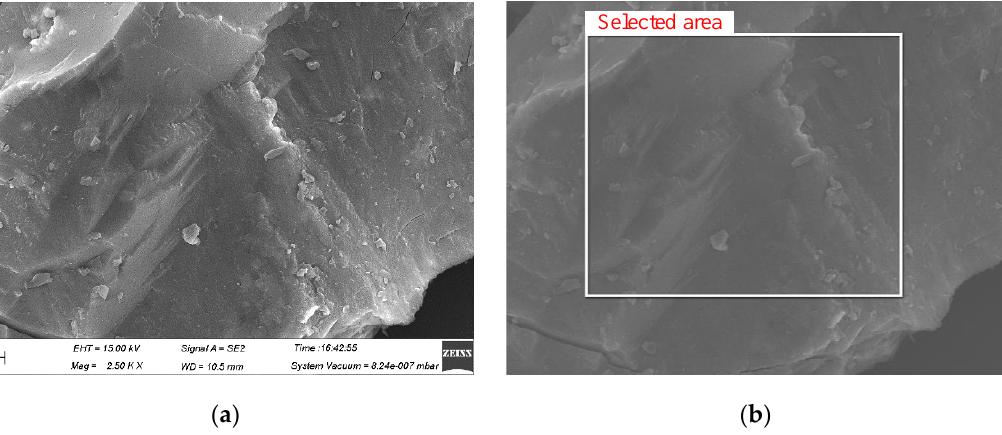
Figure 2. Characteristic test of a coal sample element. ( a ) Morphological characteristics of coal sample; ( b ) Area selected to be analyzed by X-ray energy spectrum.